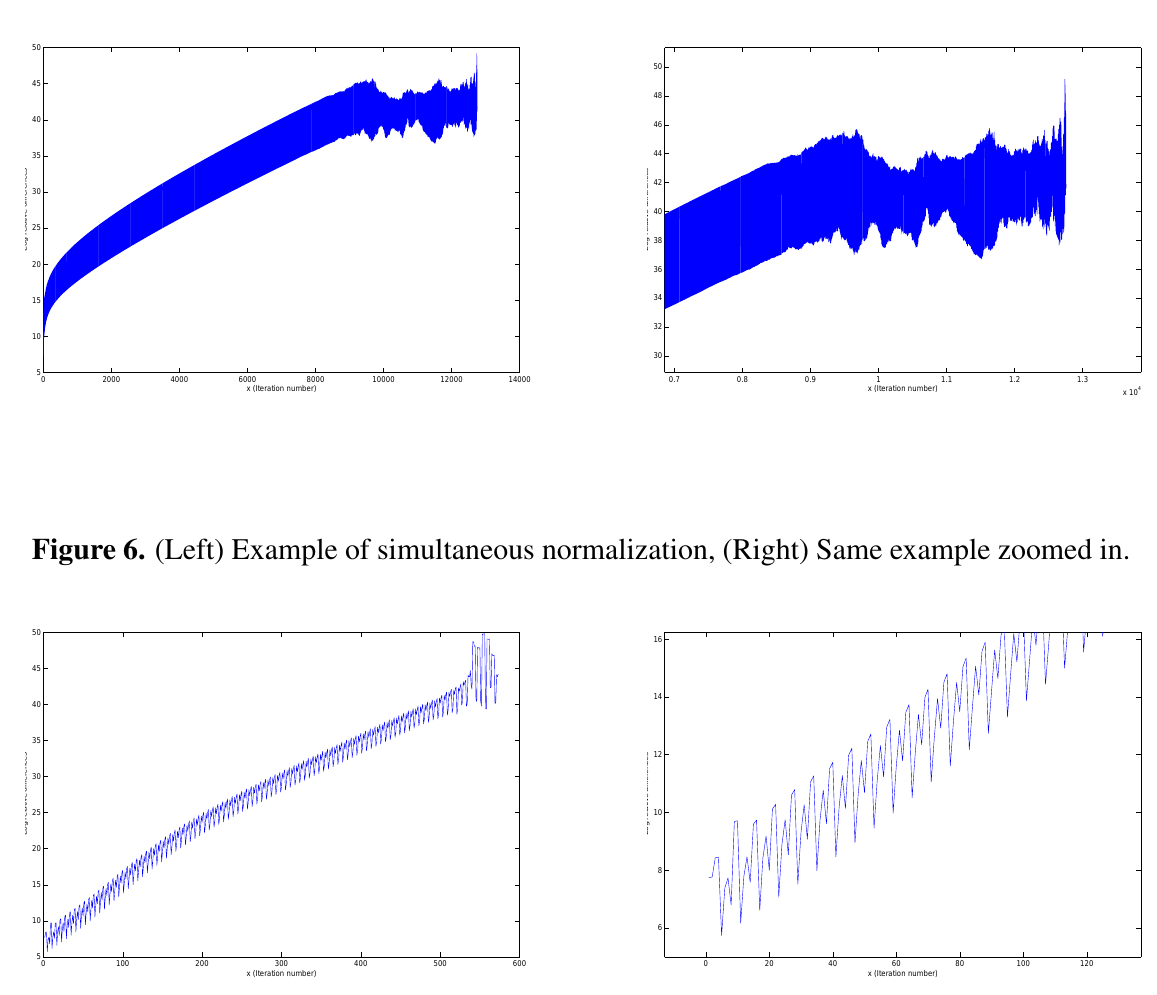
Figure 5. (Left) Example of simultaneous normalization, (Right) Same example zoomed in.